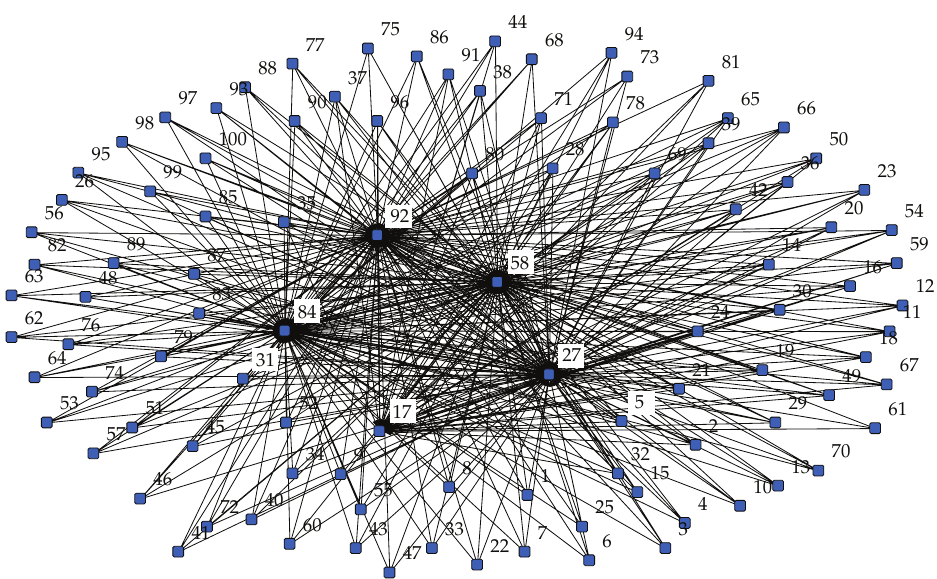
Figure 1: The graph of an interbank market